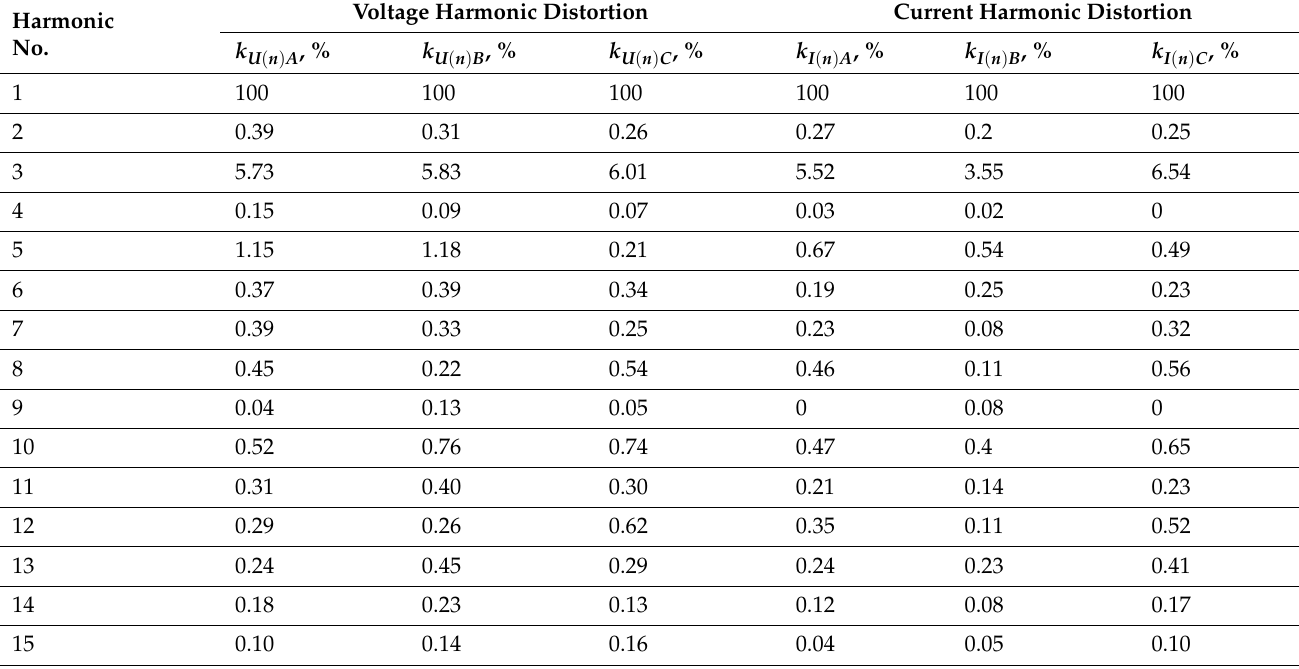
Table 4. Harmonic distortion of generator current and voltage under an unbalanced